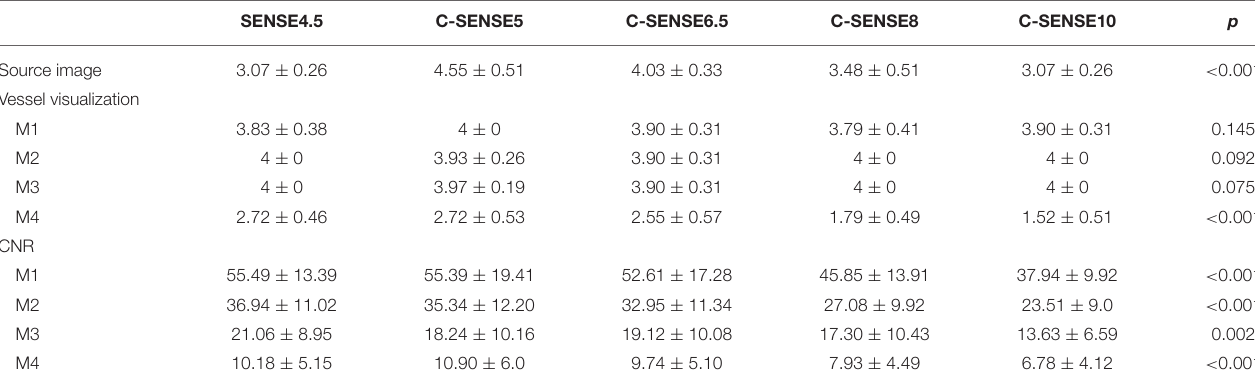
TABLE 1 | Results of source image, vessel visualization, and contrast-to-noise ratio of M1, M2, M3, and M4 segments of the middle cerebral artery when evaluated with 4D-PACK accelerated with SENSE4.5, C-SENSE5, C-SENSE6.5, C-SENSE8, and C-SENSE10 (mean value ± SD).